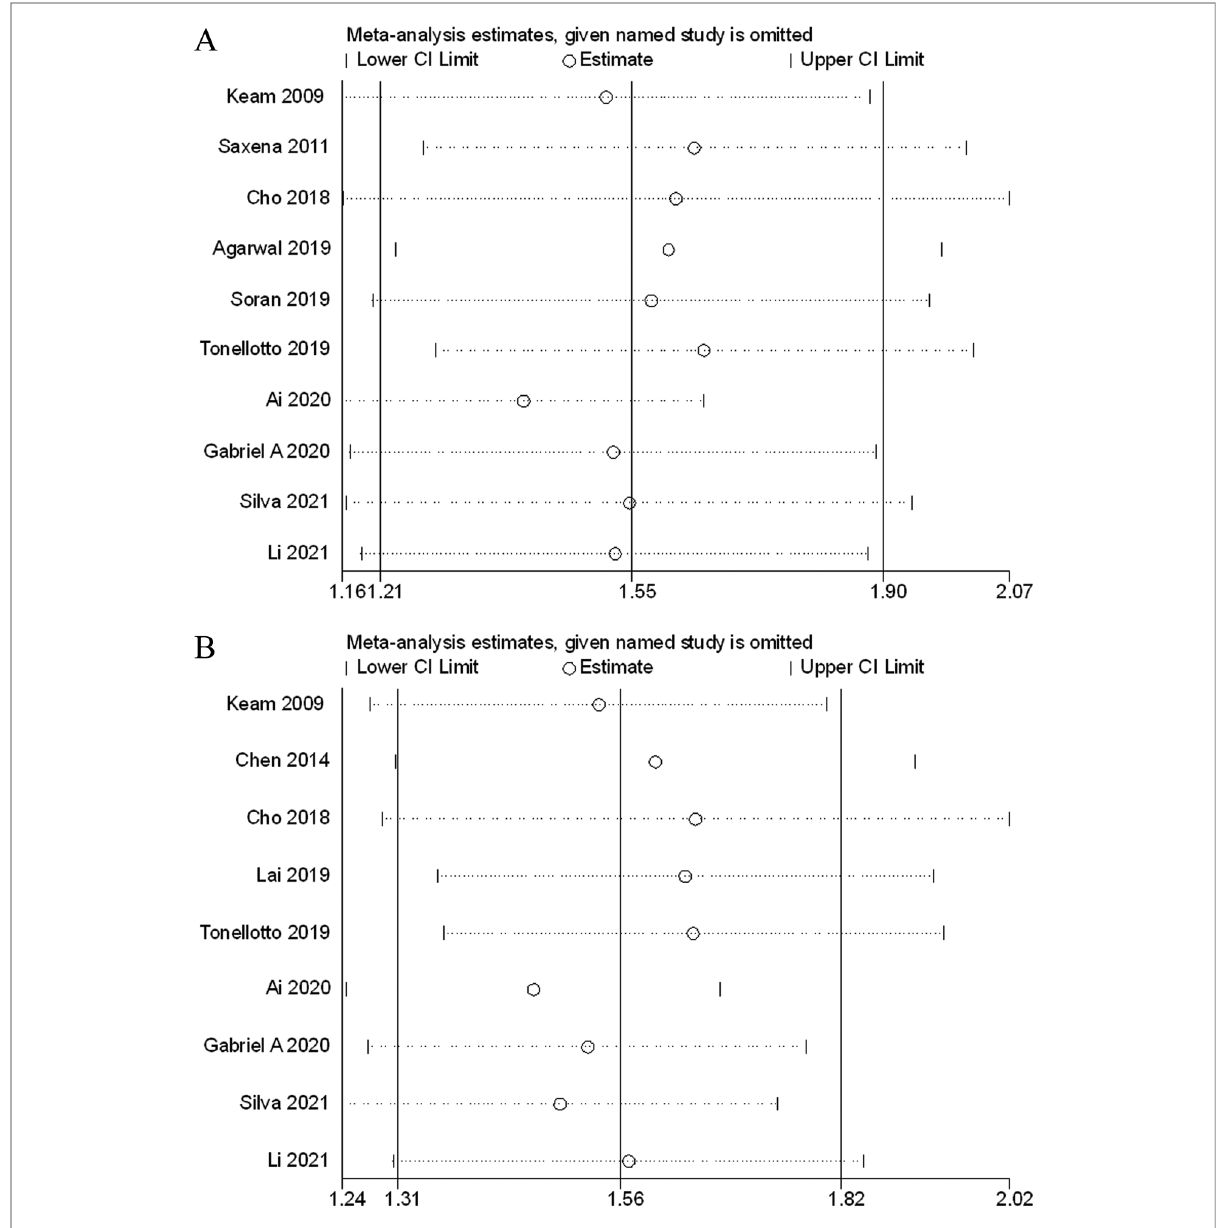
FIGURE 5 Sensitivity analysis of the association between lymph node ratio with overall survival (A), disease-free survival